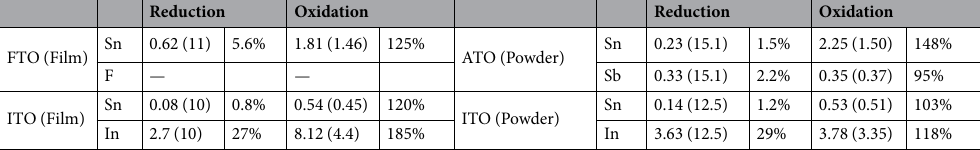
Table 1. Dissolution charge (mC cm − 2 ) during reduction and oxidation in relation to total charge. Dissolution charge (calculated based on the amount of ions measured with ICP-MS) is presented for each element. Total charge (extracted from electrochemical data) is shown in brackets next to the dissolution charge. The used charge numbers are + 1, + 2, and + 3 for Sb, Sn, and In, respectively. Ratio of dissolution charge and total charge is given in